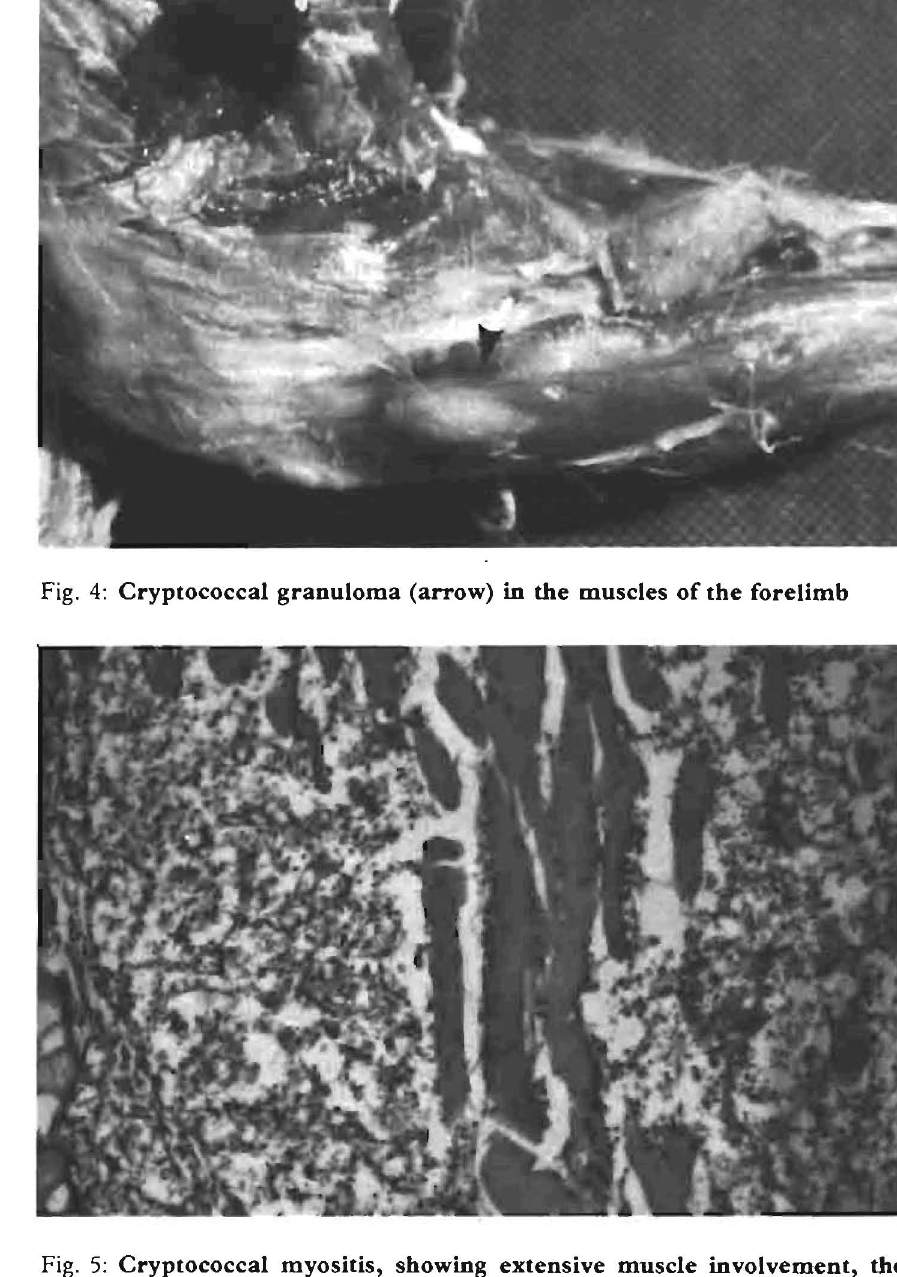
Fig. 5: Cryptococcal myositis, showing extensive muscle involvement, the presence of many yeasts and a small number of round cells. HE x